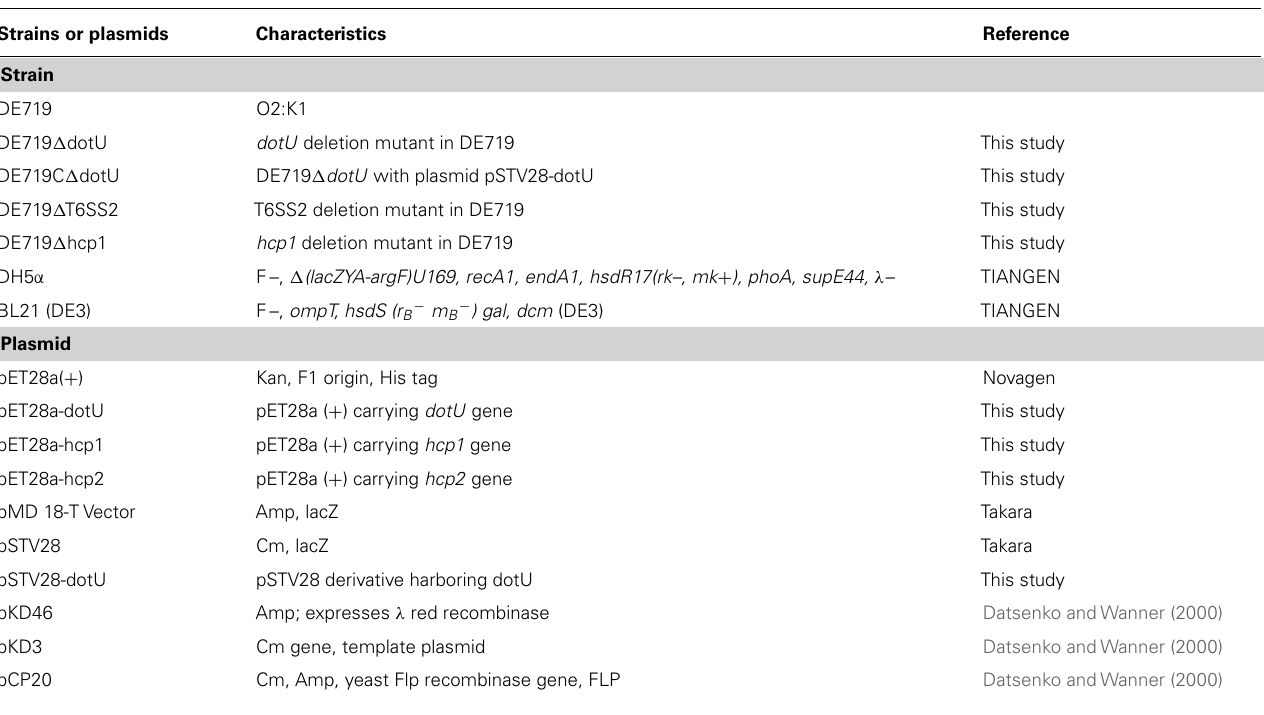
Table 1 | Bacterial strains and plasmids used in this study. Strains or plasmids